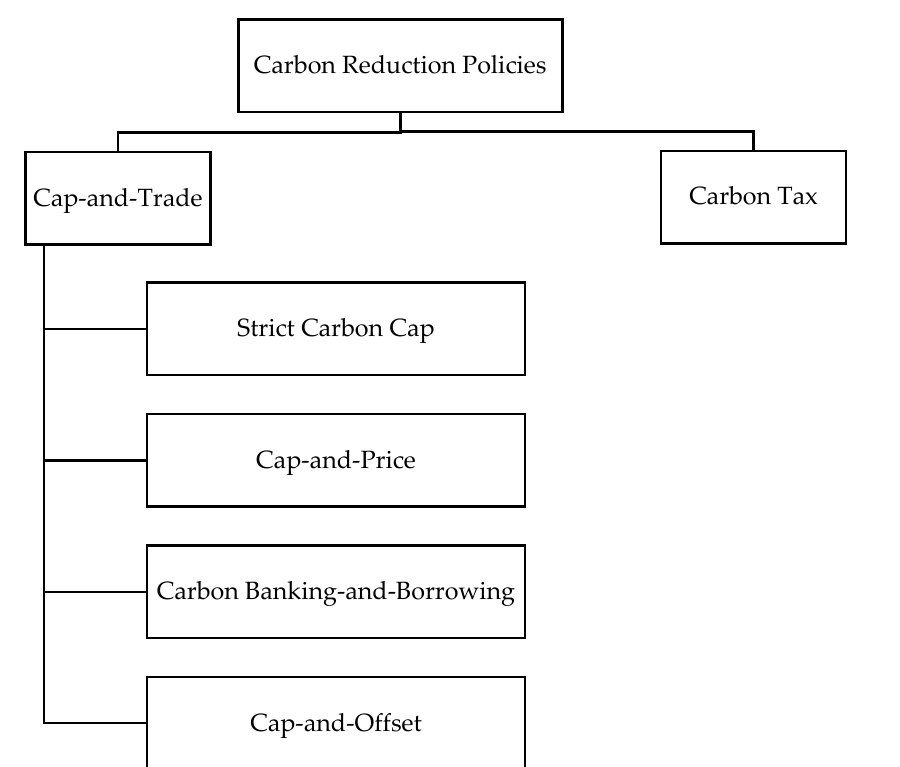
Figure 1. Popular carbon reduction schemes (Source: self-generated).